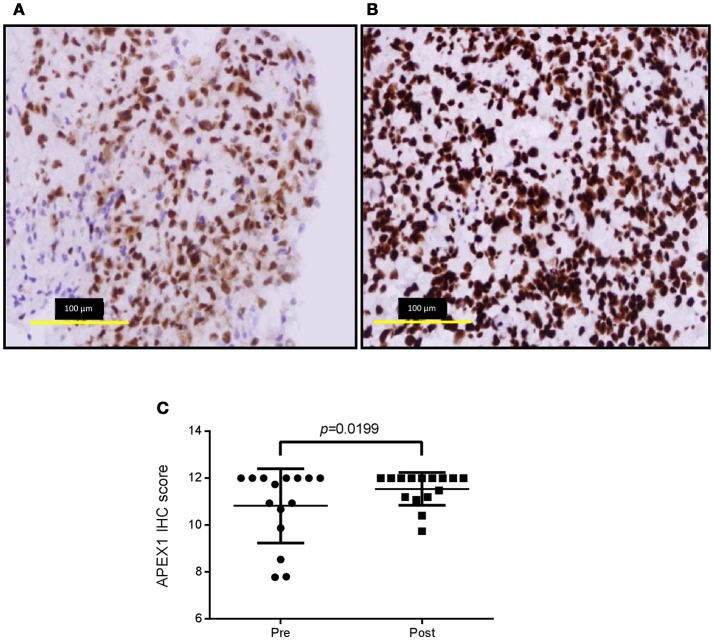
APE1 labeling of pre-treatment and post-treatment tumor specimens. Representative immunohistochemistry images of pre-treatment ((A), average score 10.8 ± 1.58) and post-treatment ((B), average score 11.5 ± 0.70) APE1 stained tumor sections and over-all staining scores for the cohort (C). Positive and negative control tissues and isotype reagent controls were included. Staining was scored for both intensity (0-3) and percentage of positive tumor nuclei (1, 0–25%; 2, >25 – <50%; 3, 50–75%; 4, >75–100%).